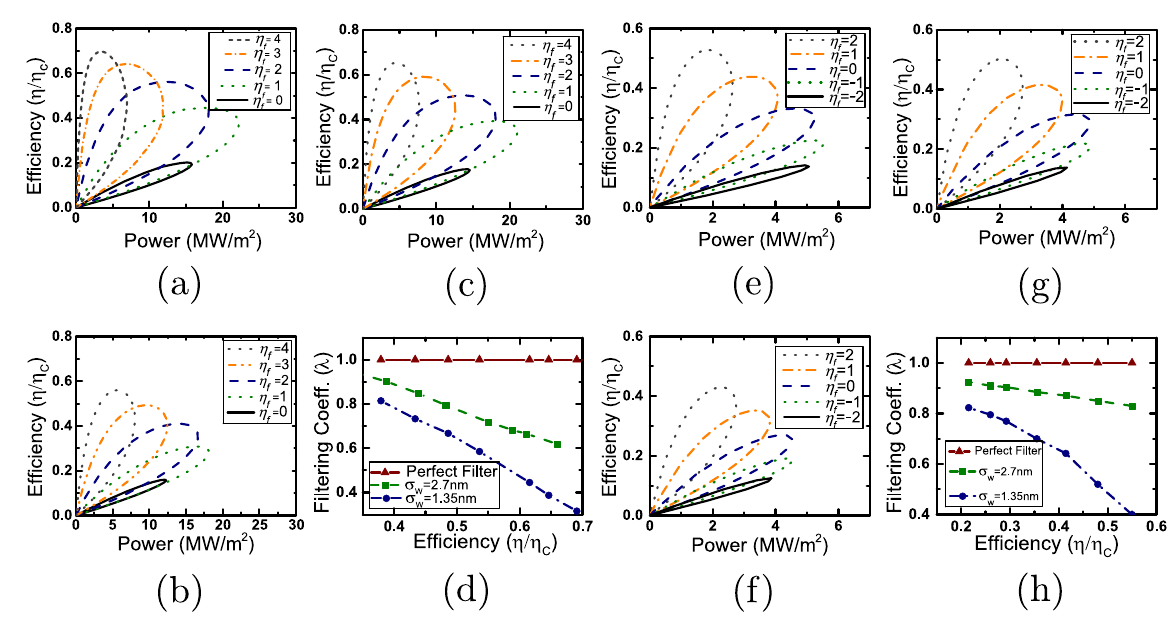
E E c b f k T B ( b ) with a thin energy barrier ( σ = 2.7 nm , E = 150 meV ) w b